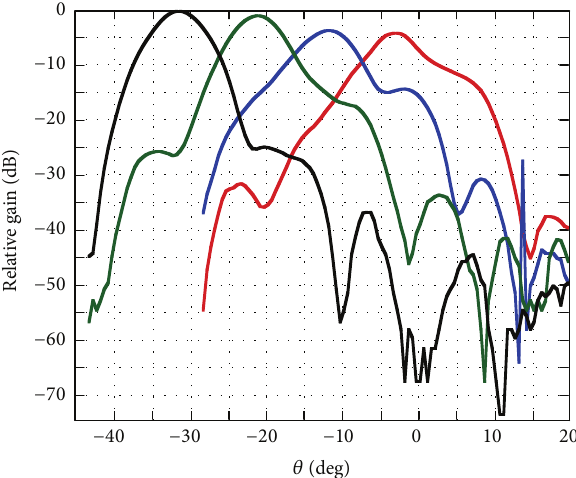
Figure 20: Shifted angle versus off-axis displacement.